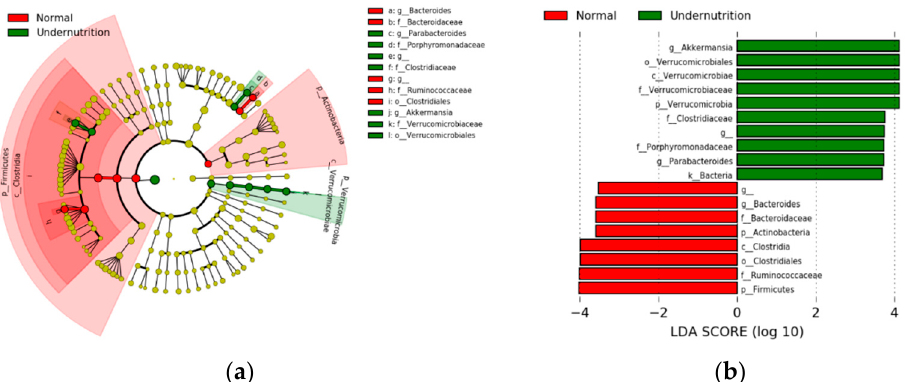
Figure 5. Biomarker determination of gut microbiota using the taxonomic profile method of LefSe ( a ) and linear discriminant analysis score ( b ). The bar chart and cladogram show taxonomic discrimination between the two groups based on the cladogram and LDA method. Taxa with an alpha value of 0.05 and LDA score < 3.5 were considered significant.